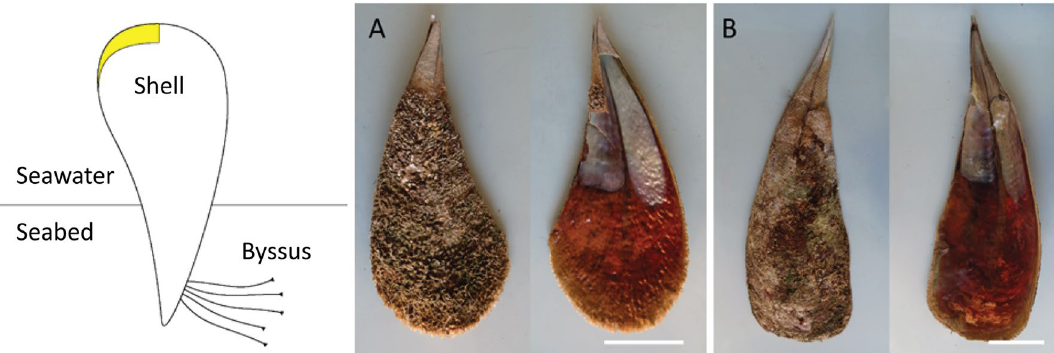
Figure 1. P. nobilis shells. (left) A schematic representation of a P. nobilis , in yellow the portion of shell collected for a first analysis. (right) Pictures of the extern and intern of the shell valves of P. nobilis from site ( A ) (about 40 cm long) and site ( B ) (about 60 cm long); two different morphology of the shell can be observed. Scale bar: 10